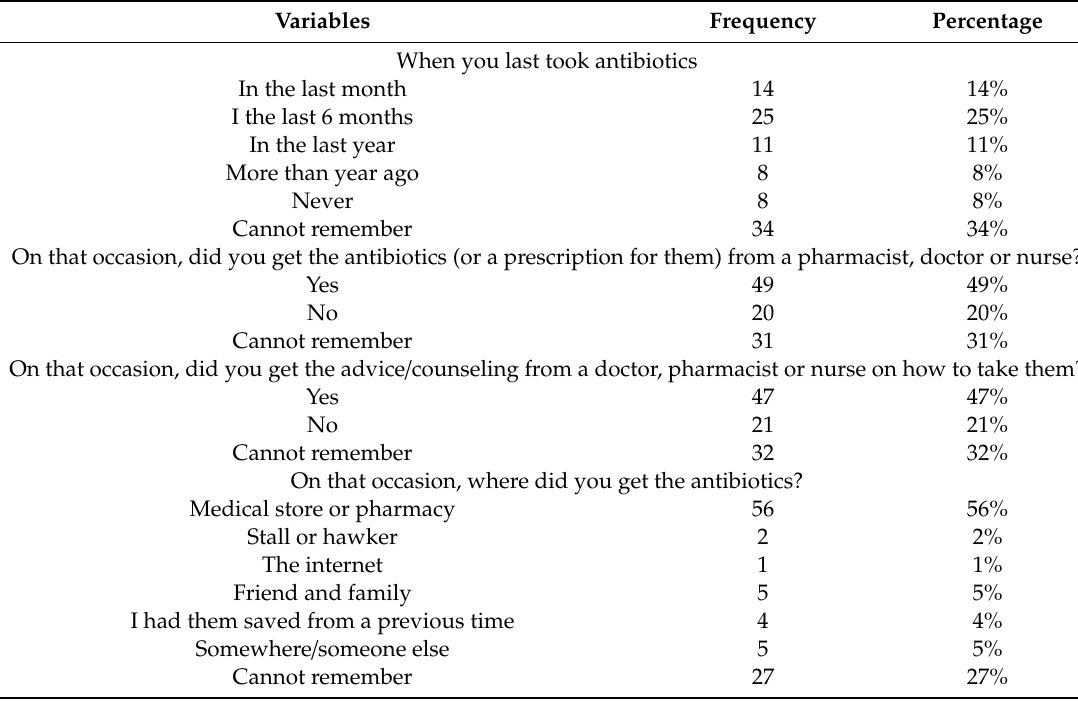
Table 4. Socio-demographic characteristics of study